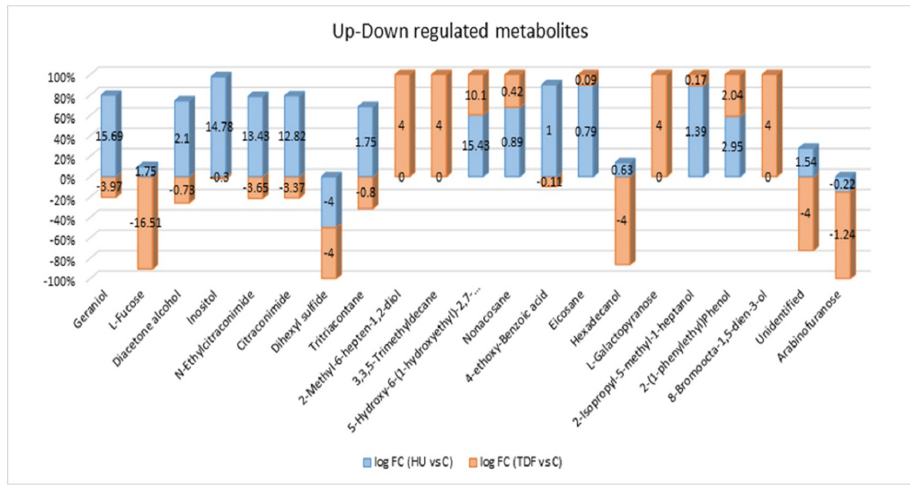
intervals for the VIP values were found to be 95%.